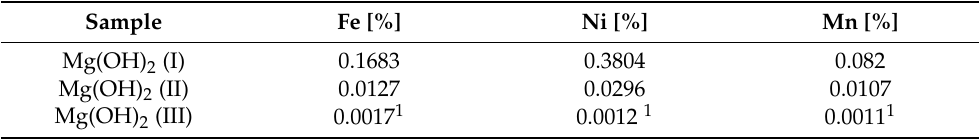
Table 4. Results of determination of Fe, Ni and Mn impurities in batch III fractions I, II and III.